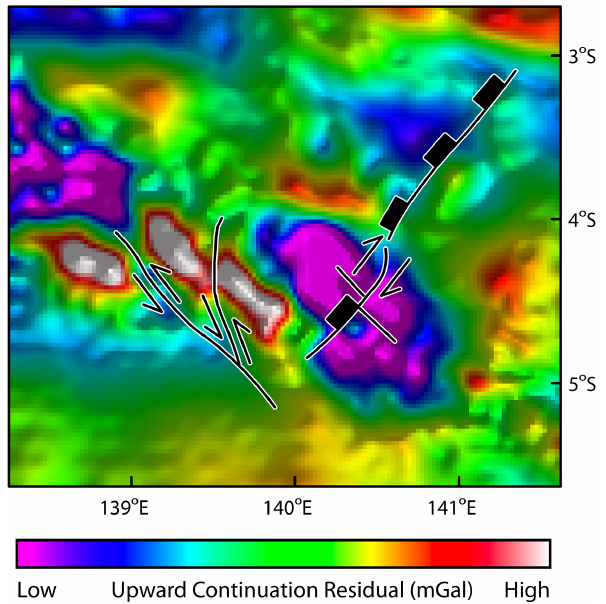
Fig. 9. There were several cases where we could identify lineaments where we could infer an apparent sense of displacement. For exam- ple, we show that there may have been some left-lateral displace- ment of gravity highs (red–white colours), as well as a possible NE- trending extensional fault with a right-lateral sense of movement. The grid that is shown here was generated by subtracting the 40km upward continuation (UC) from the 5km UC Bouguer grid. The grid is illuminated from the